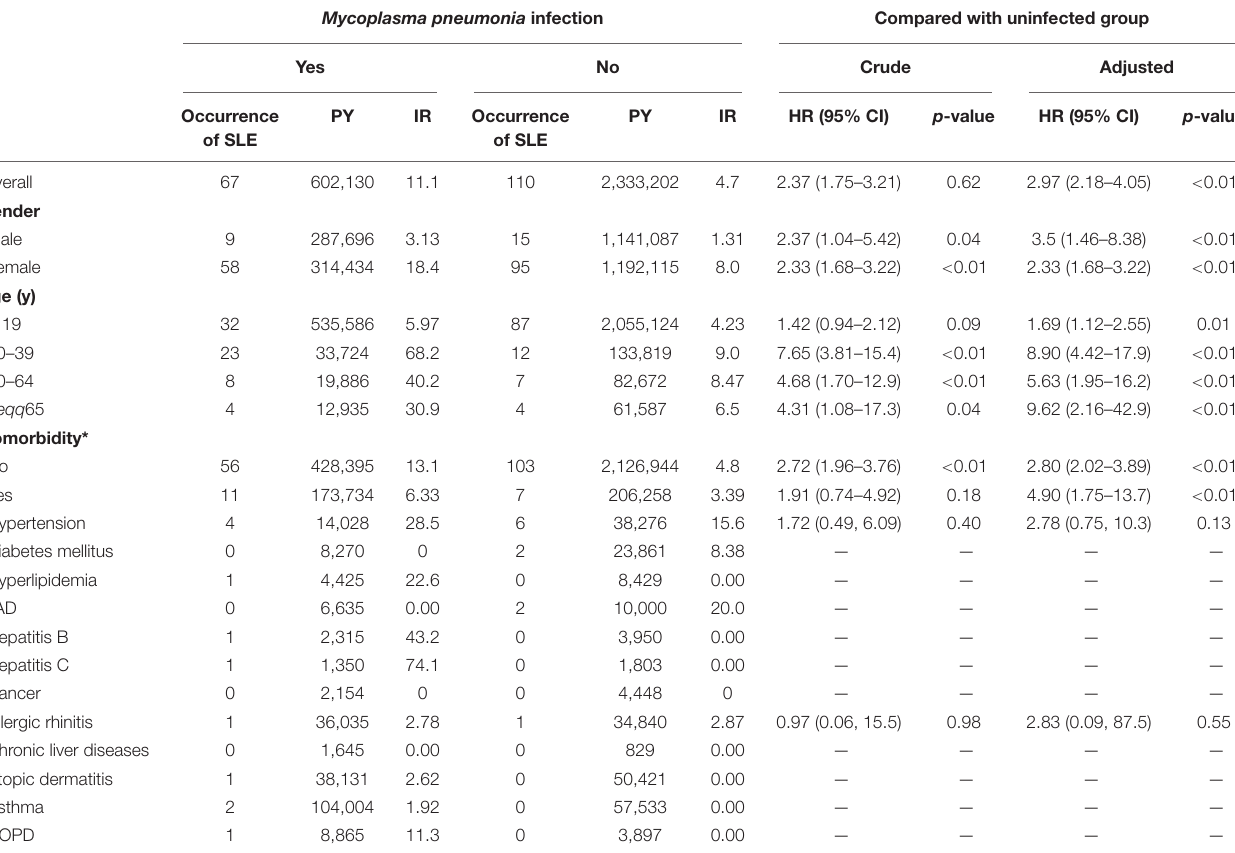
TABLE 2 | Incidence and hazard ratio of systemic lupus erythematosus in the study cohort. Mycoplasma pneumonia infection Compared with uninfected group